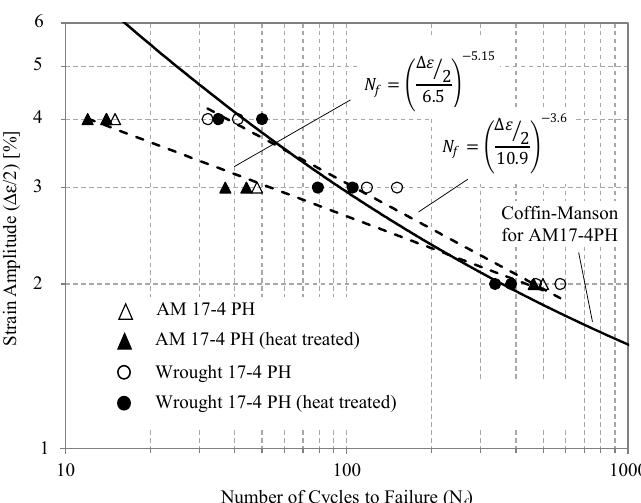
Figure 11. Coffin–Manson universal slopes comparison to measured fatigue data and proposed ULCF regression.